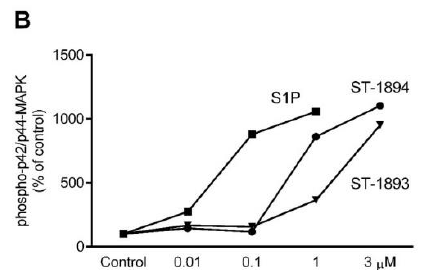
Figure 2. Characterization of ST-1893 and ST-1894 for agonistic and antagonistic activity on each sphingosine 1-phosphate receptor (S1PR) subtype. Starved confluent Chinese hamster ovary (CHO)-K1 cells, which stably overexpress S1P 1 , S1P 2 , S1P 3 , S1P 4 , or S1P 5 receptors, were treated for 10 min with increasing concentrations of S1P, ST-1893 ( left panels ), and ST-1894 ( right panels ) (all in µ M), or with 100 nM S1P in the presence of increasing concentrations of ST-1893 or ST-1894. Protein extracts were prepared, separated by SDS-PAGE, transferred to nitrocellulose, and subjected to Western blot analysis as described in Section 4. Membranes were incubated with phospho- and total p42/p44-mitogen-activated protein kinase (MAPK). Blots in ( A ) show one representative out of three independent experiments. The graph in ( B ) shows the quantification of p42/p44-MAPK activation in CHO-S1P 1 cells and depicts the means of three independent experiments.